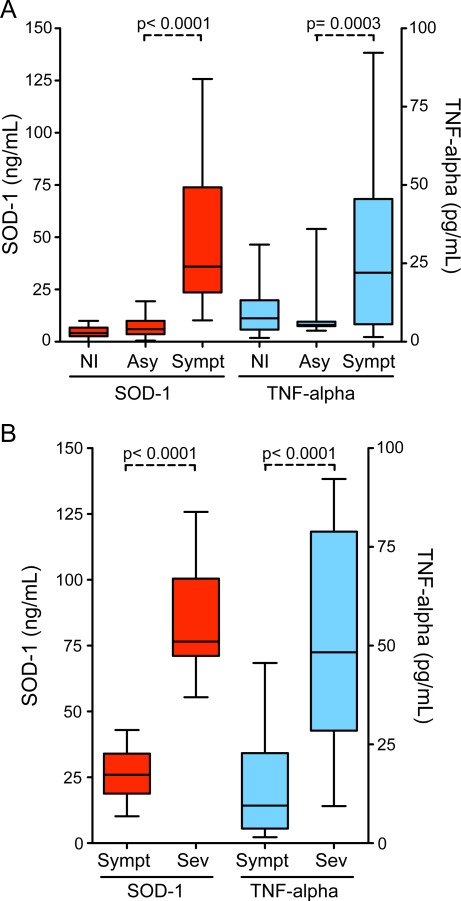
Plasma SOD-1 and TNF-alpha as markers of severe vivax malaria.A, SOD-1 protein and TNF-alpha plasma levels according to vivax malaria clinical severity. NI, non-infected volunteers (n = 90); Asy, asymptomatic infection (n = 60); Sympt, symptomatic infection (n = 69). Differences among the groups were calculated using the Kruskal Wallis analysis of variance with Dunn's multiple comparisons test. B, Plasma levels of SOD-1 and TNF-alpha in individuals with mild P. vivax infection (n = 50) compared to those with severe vivax malaria (Sev; n = 19). Boxes represent median and interquartile interval; whiskers represent maximum and minimum values. Differences were estimated using Mann-Whitney test. Lines represent median values. P values are shown in each graph.